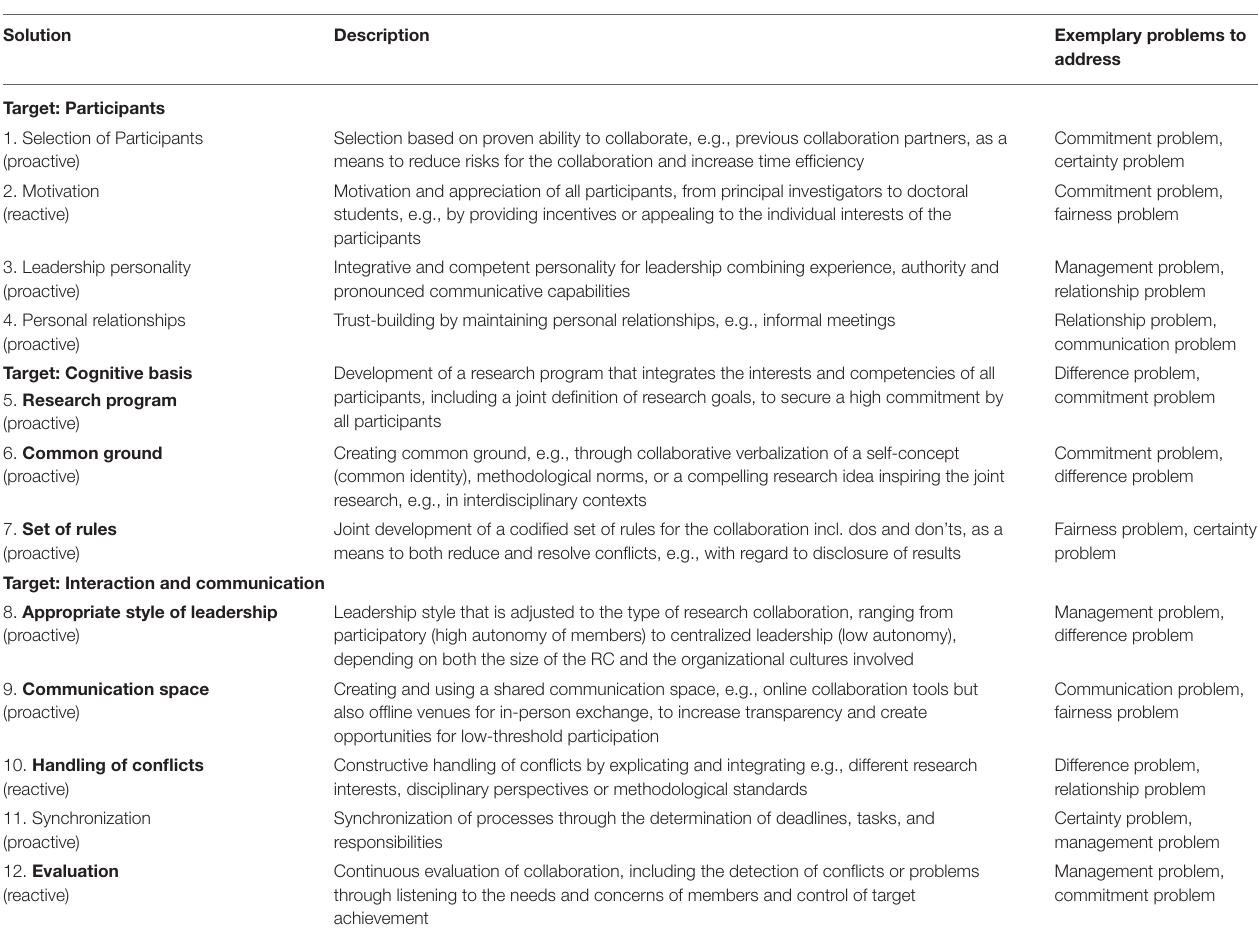
TABLE 5 | Twelve solutions to collaboration